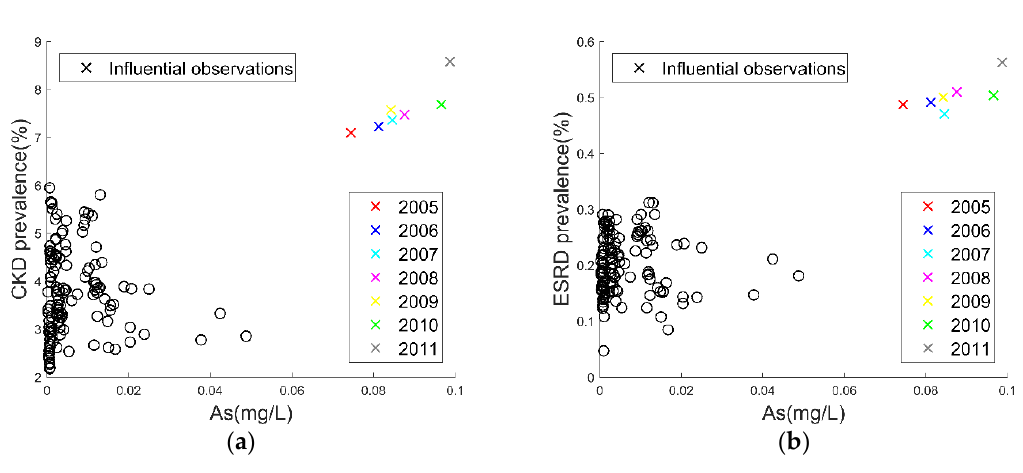
Figure 2. The relationship between arsenic in groundwater and age-standardized chronic kidney disease (CKD)/ end-stage renal disease (ESRD) prevalence rates (2005–2011): ( a ) the CKD prevalence rate in groundwater and ( b ) the ESRD prevalence rate in groundwater. The influential observations are labeled by the color-coded year symbols ‘×’.